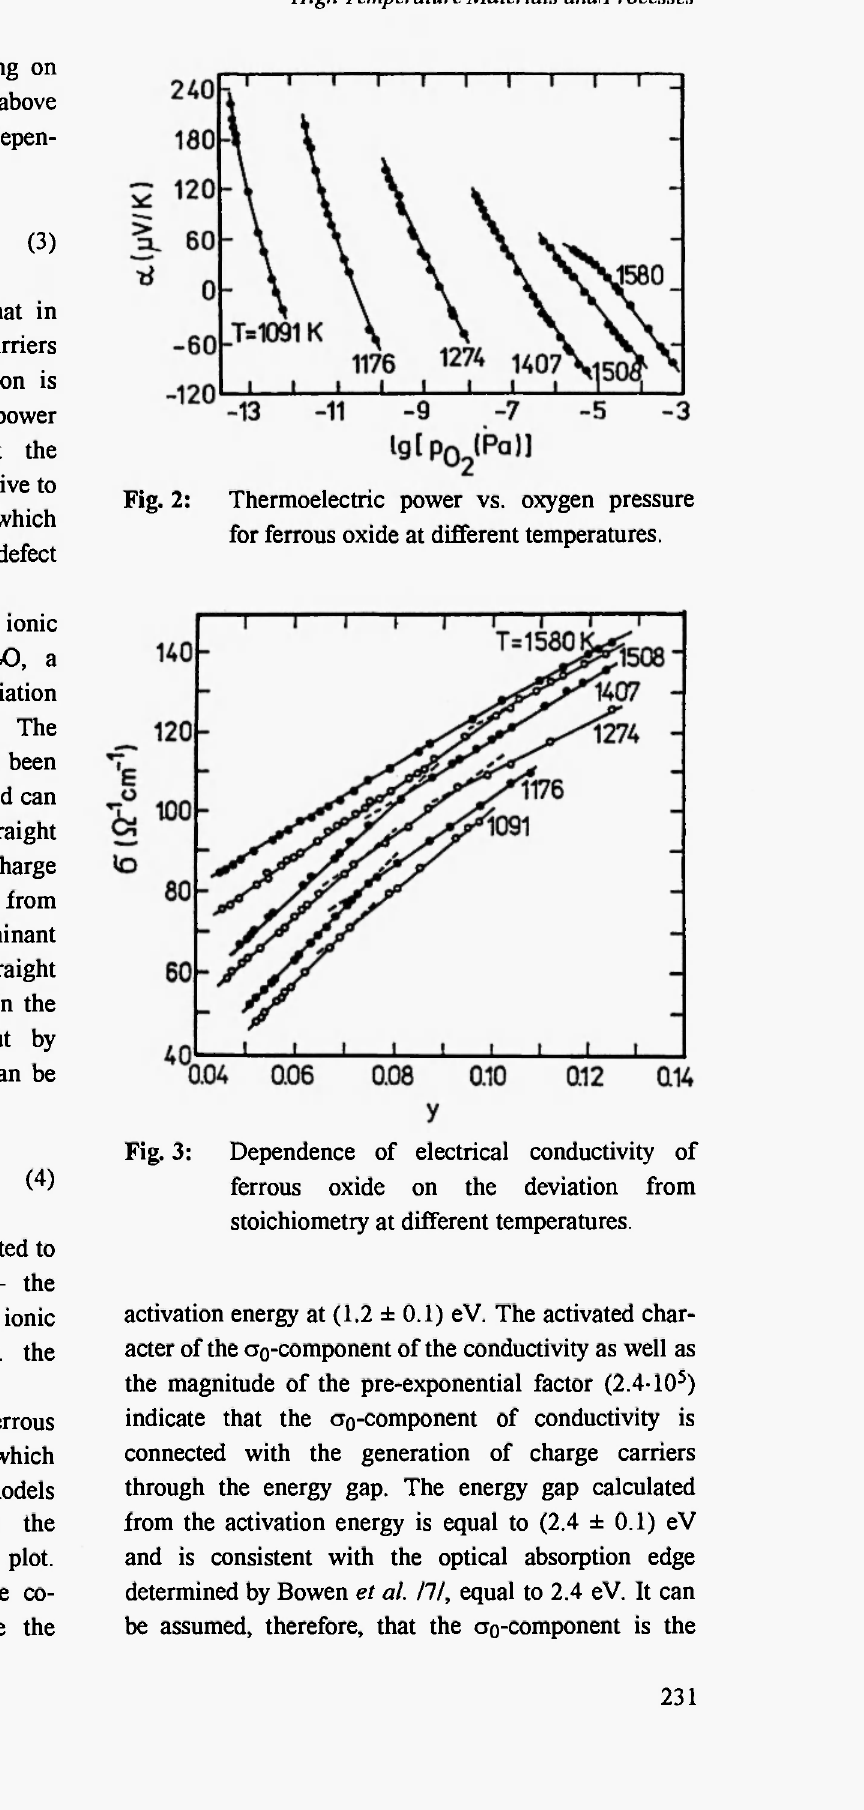
activation energy at (1.2 ± 0.1) eV. The activated char- acter of the σο -component of the conductivity as well as the magnitude of the pre-exponential factor (2.4· 10 5 ) indicate that the σο -component of conductivity is connected with the generation of charge carriers through the energy gap. The energy gap calculated and is consistent with the optical absorption edge determined by Bowen et al. Ill, equal to 2.4 eV. It